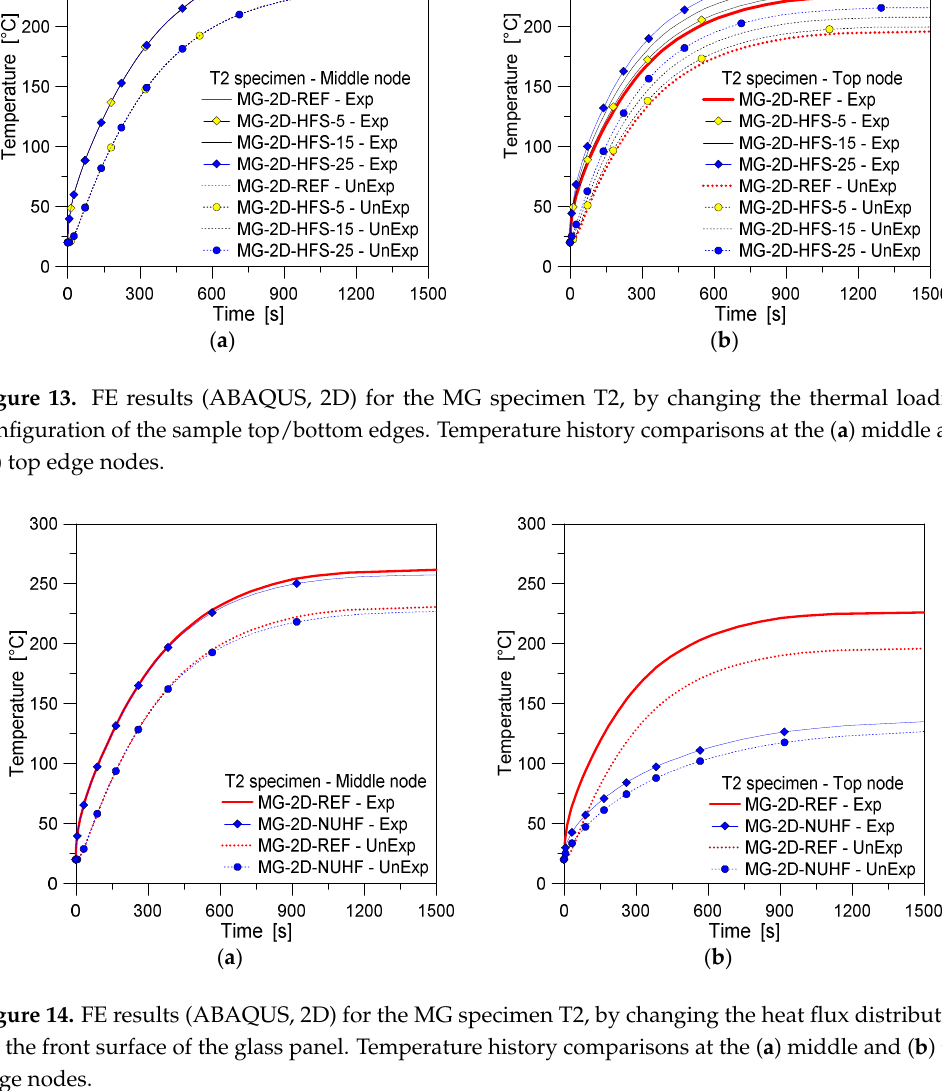
Figure 13. FE results (ABAQUS, 2D) for the MG specimen T2, by changing the thermal loading configuration of the sample top/bottom edges. Temperature history comparisons at the ( a ) middle and ( b ) top edge nodes.